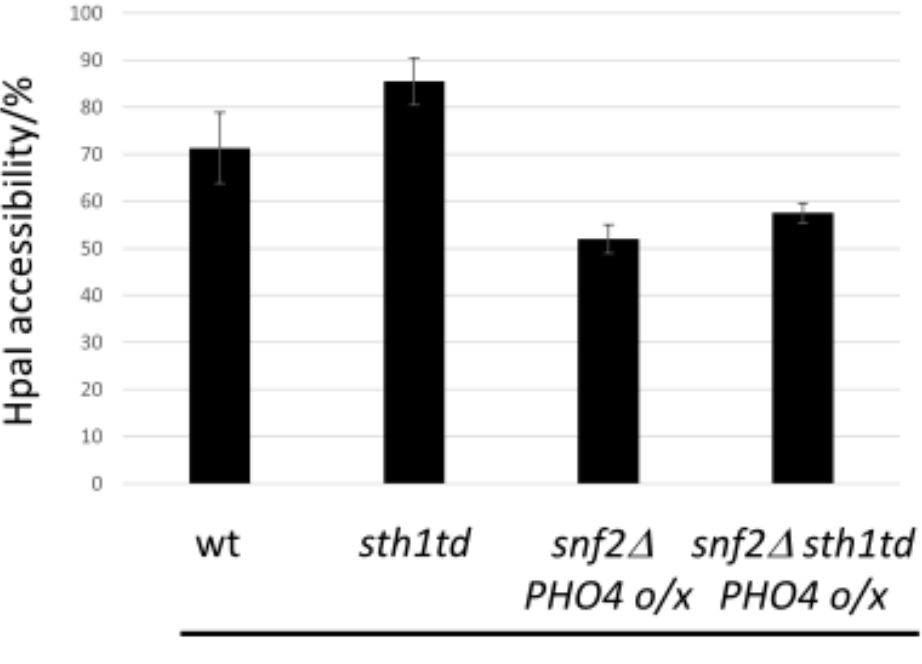
Figure 6. RSC does not help but rather hinders PHO8 promoter nucleosome remodeling with or without SWI/SNF. HpaI accessibility values analogous to Figure 1B for the indicated genotypes and growth conditions.